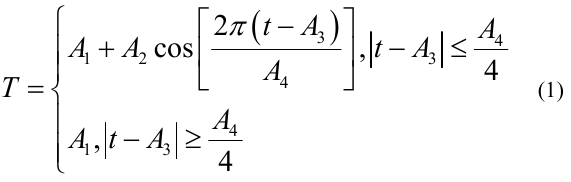
Figure 1. Daily average of 10.7cm Solar Radio